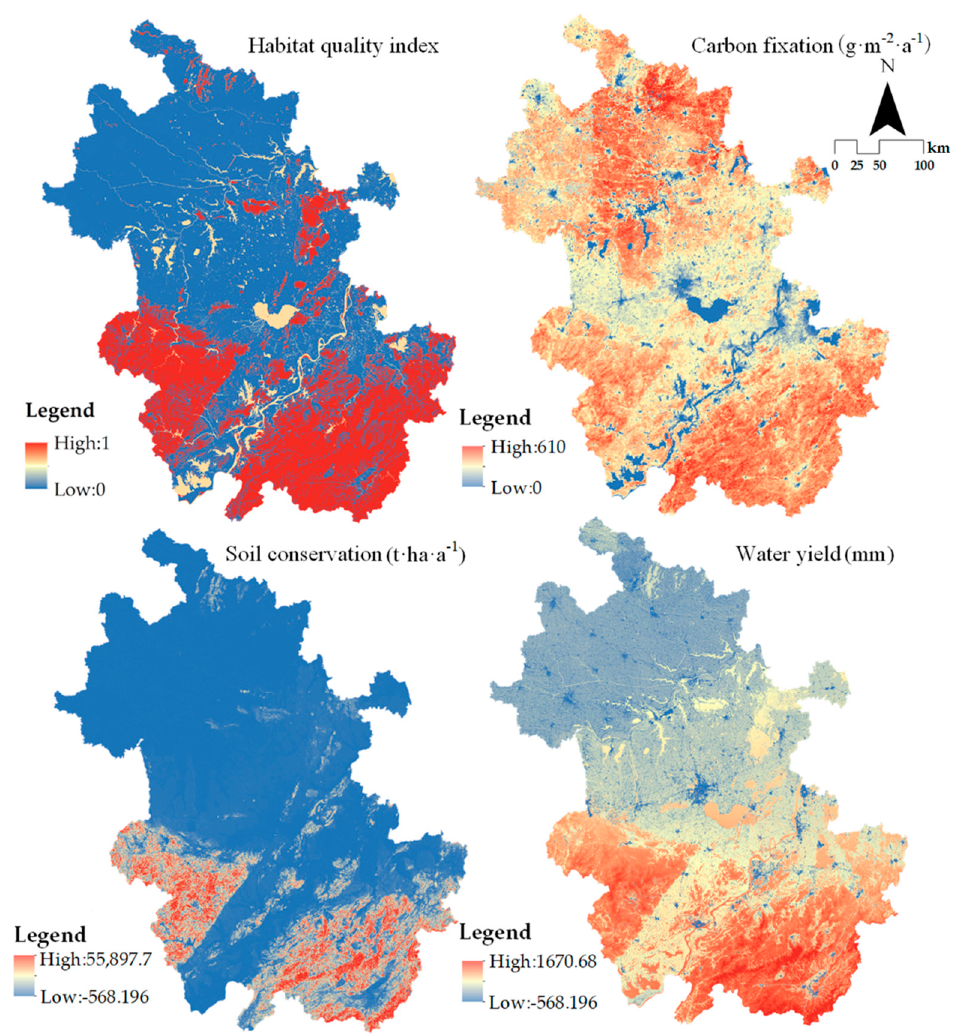
Figure 3. Spatial patterns of ecosystem services in Anhui Province.